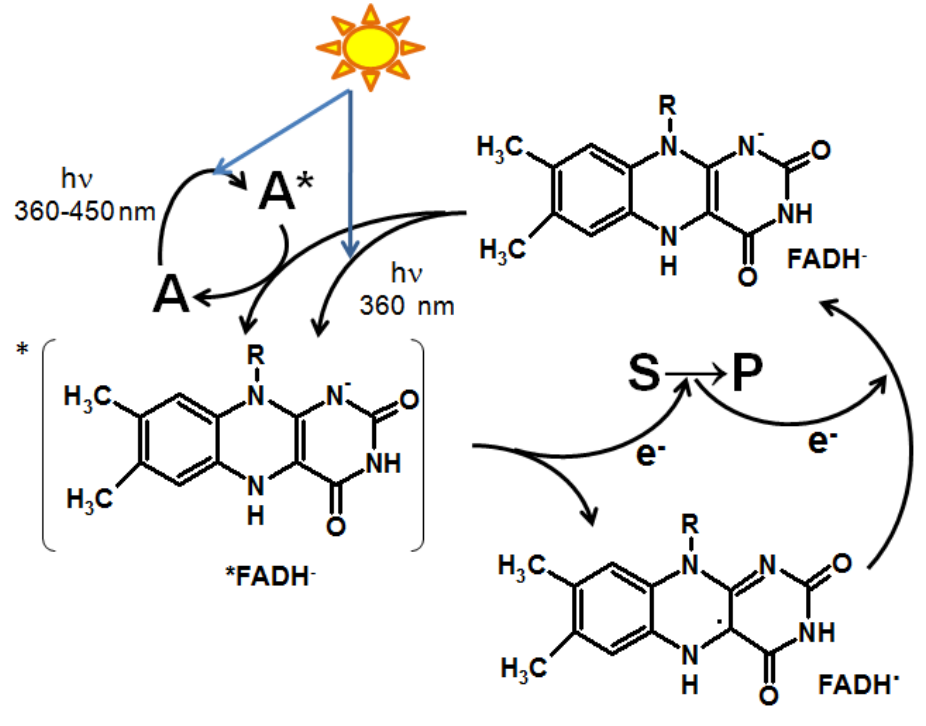
Figure 22. The photocycle of DNA photolyases. In CPF proteins, in addition to the main FAD chromophore, there are pigments (derivatives of flavins and pterins) that act as a “light-harvesting antenna” (Figure 23). Five molecules have been described as antennas of CPF